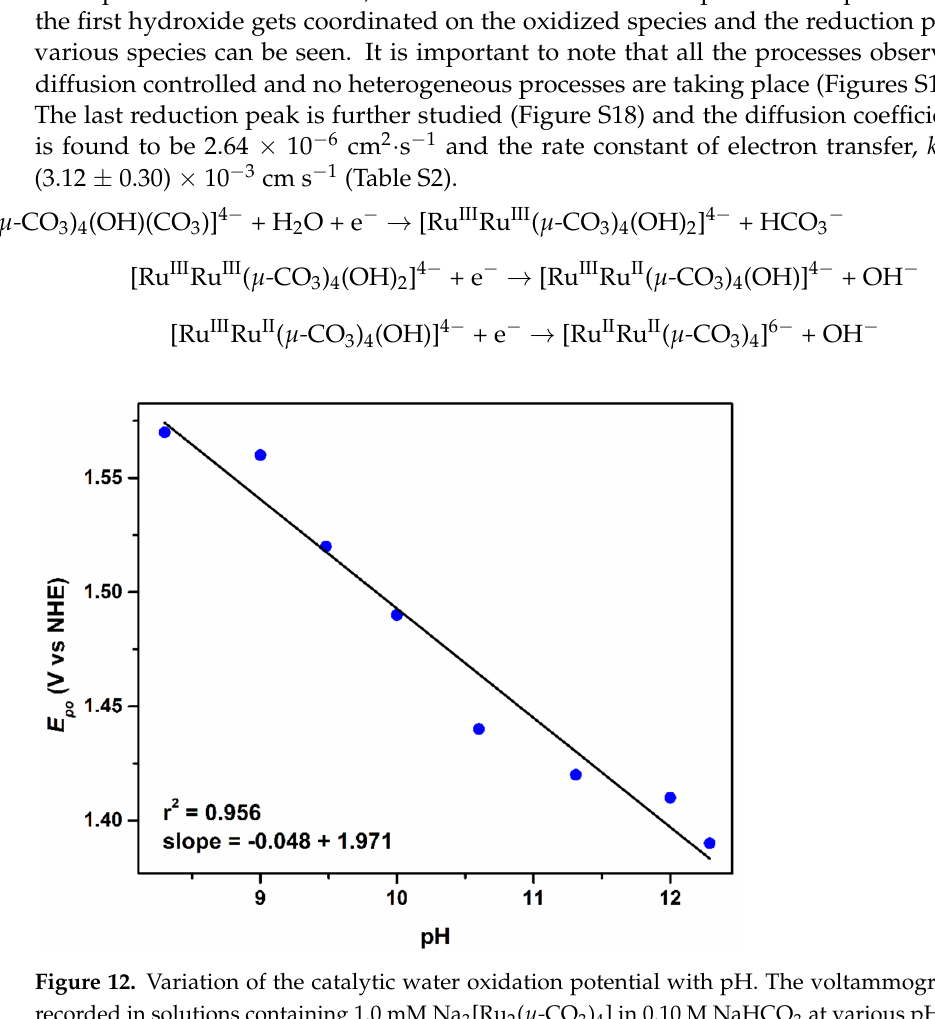
served at λ = 337 nm ( ε = 336 dm 3 · mol − 1 · cm − 1 ) and 412 nm ( ε = 834 dm 3 · mol − 1 · cm − 1